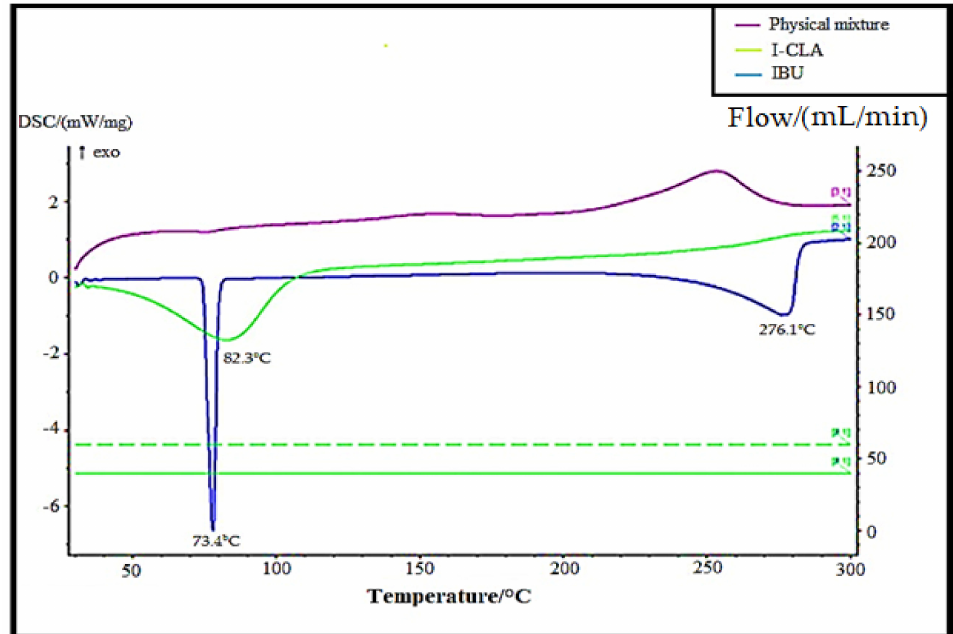
Figure 3. DSC thermograms of pure IBU, physical mixture, and IBU-loaded chitosan–PC90G with gum arabic